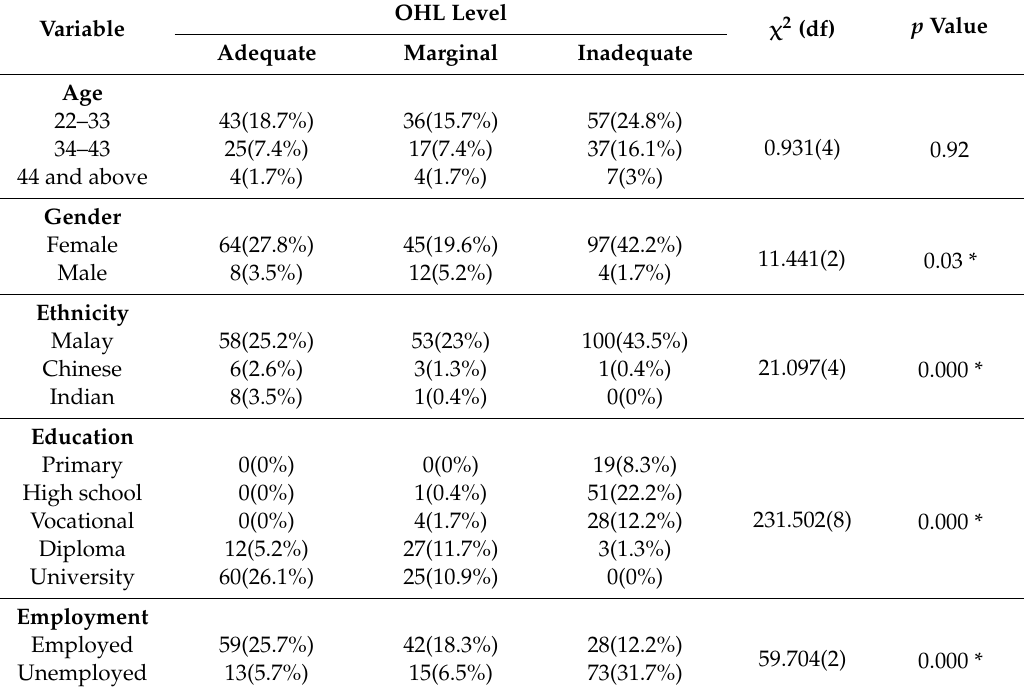
Table 5. Demonstrates the distribution of parents with their level of OHL across sociodemographic characteristics.